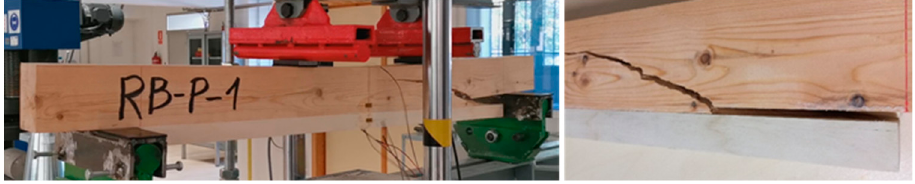
Figure 4. Picture of the final delamination and pine fracture. RB_P_1 specimen. Type A.